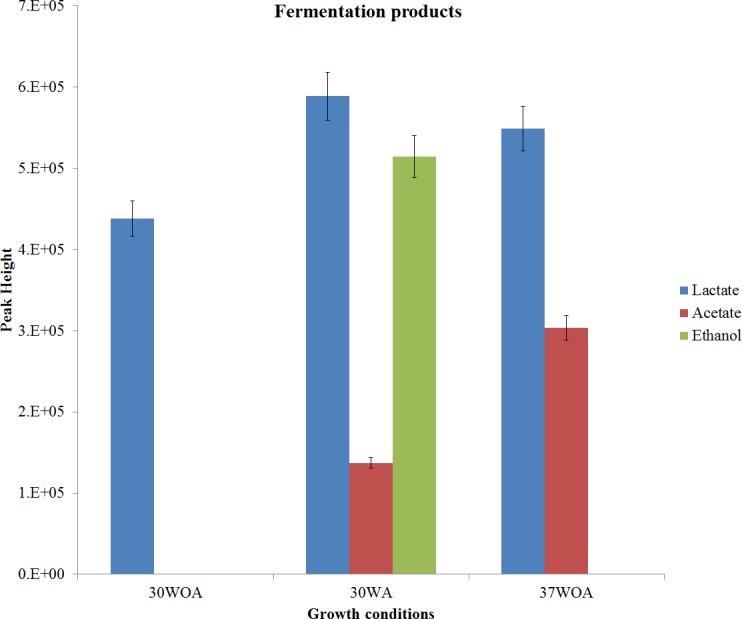
Measurement of extracellular by-products.Measurement was obtained from 30 °C with agitation (150 rpm) (30WA), 30 °C without agitation (30WOA) and 37 °C without agitation (37WOA). Measurement was carried after five hours of cultivation (mid-exponential phase). Values are given as mean ± standard deviation (n = 5, biological replicates).